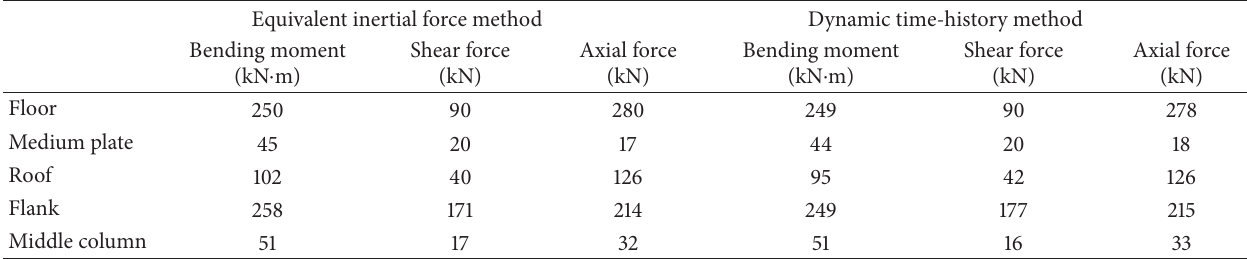
Figure 9: The shear force diagram of the maximum dynamic internal force of two layers and three crosses station structure (kN). Table 8: The maximum dynamic internal force of station structure according to equivalent inertial force method and dynamic time-history